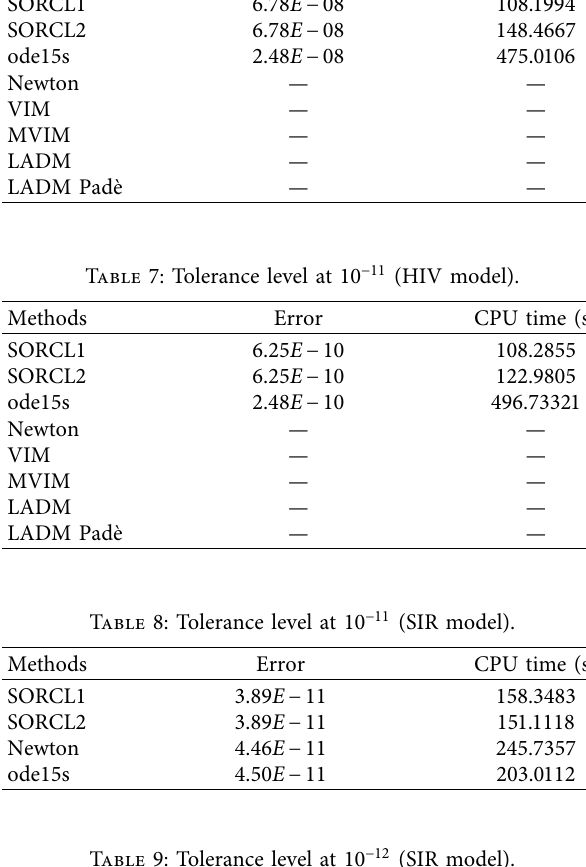
Table 6: Tolerance level at 10 − 9 (HIV model). Methods